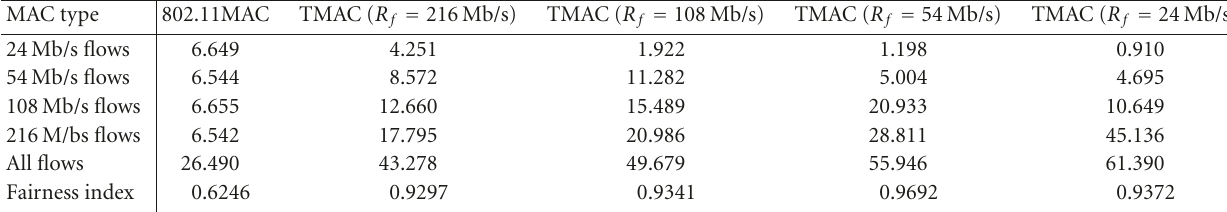
Table 6: Throughput (Mb/s) and fairness index.